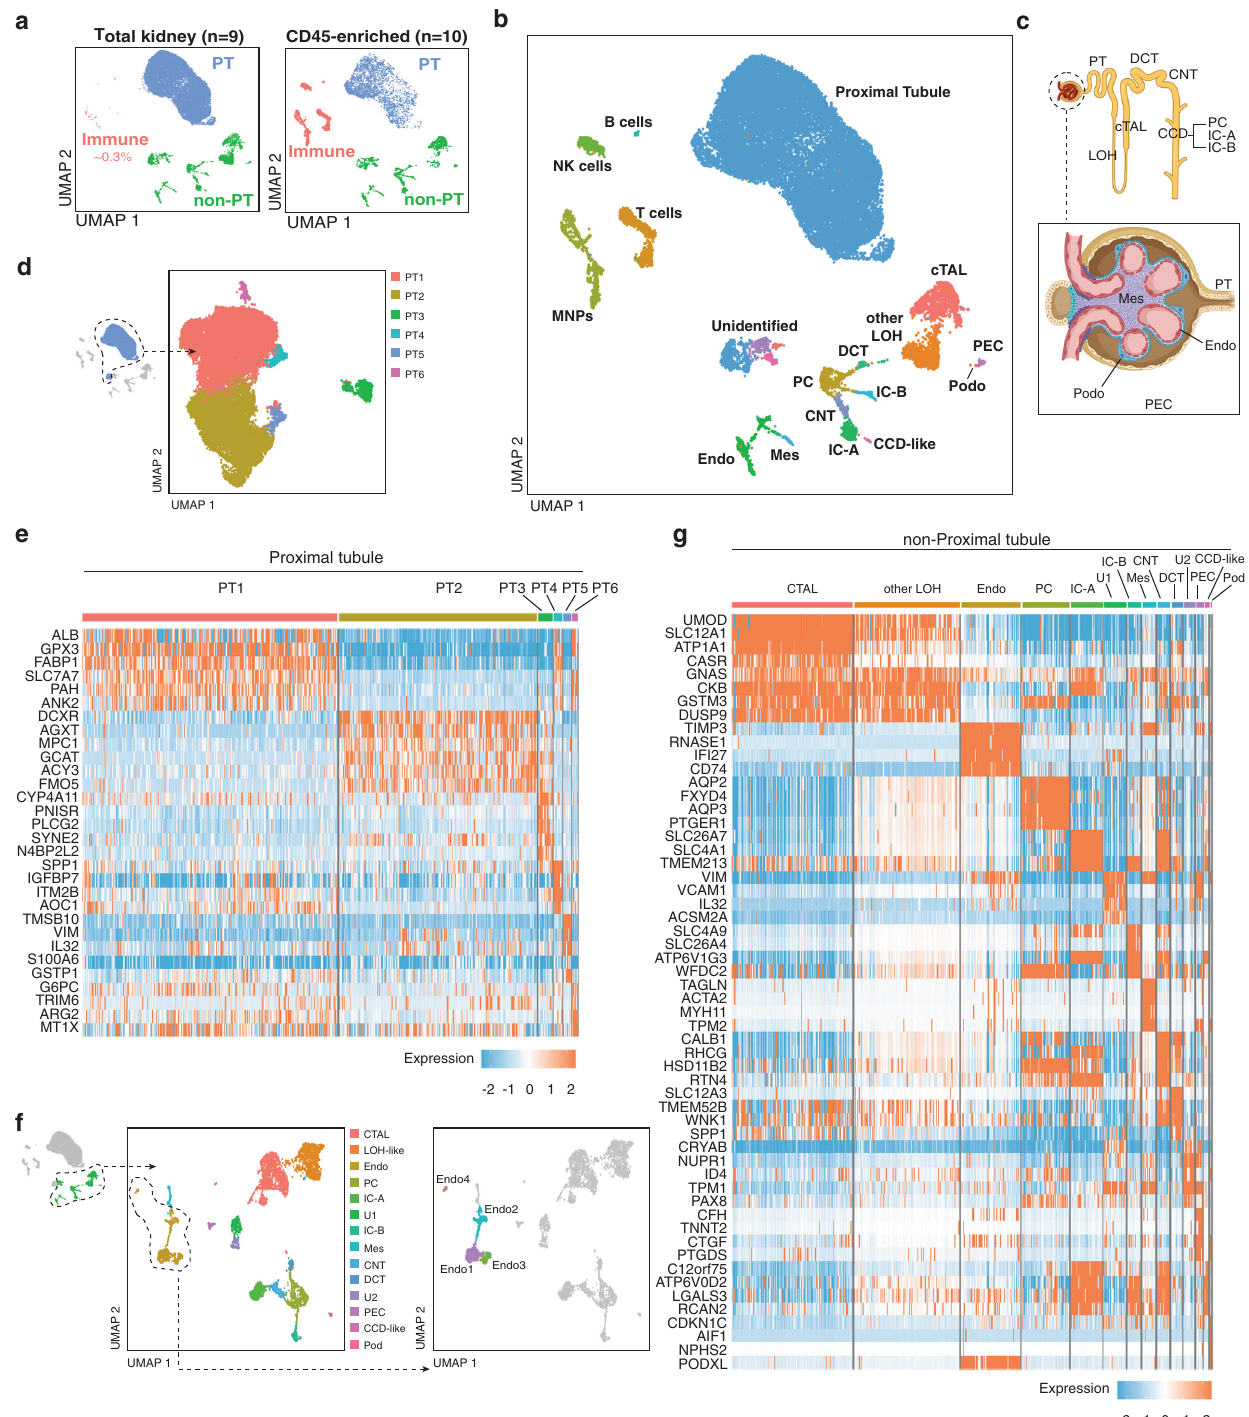
Fig. 1 | Identi fi cation and annotation of kidney parenchymal cells. a Different cell type proportions were captured by sequencing total kidney homogenate and CD45-enrichedsamplestocreatethetotalcombineddataset. b UMAPclusteringof totalcombineddatasetwithcelltypeannotations. c Graphicaldepictionoflocation of nephron cell types captured within the data. d UMAP plot of compartment- speci fi canalysisof20772proximaltubularcells,comprising6clusters. e Heatmap showing the expression levels of cluster marker genes. f UMAP plot of compartment-speci fi c analysis of 4436 non-proximal tubular parenchymal cells,